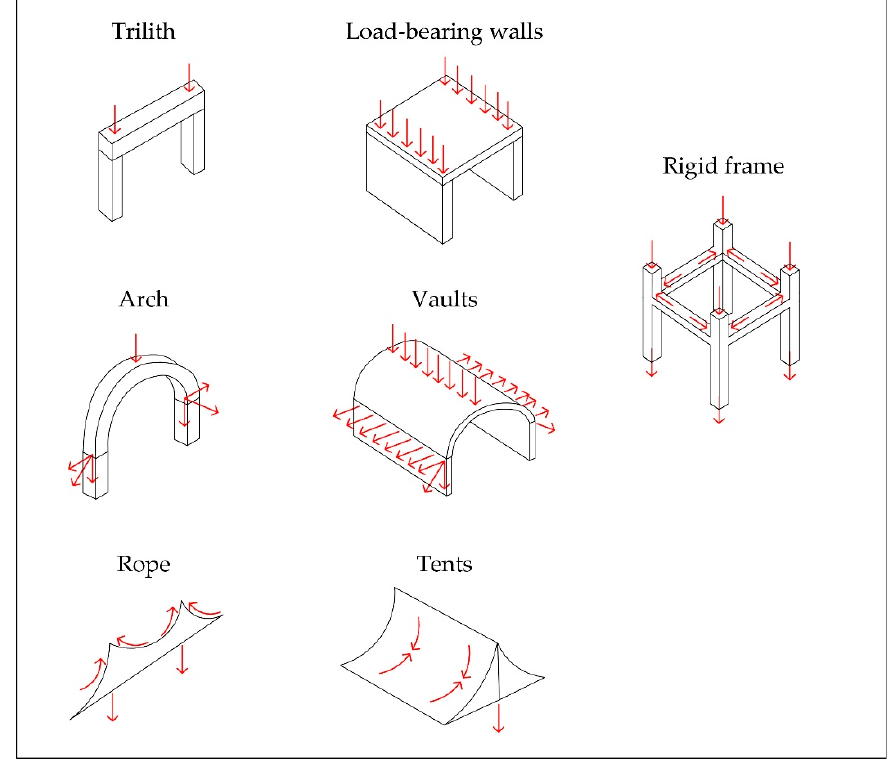
Figure 4. Building constructive systems structural criteria (drawing by G.B.).